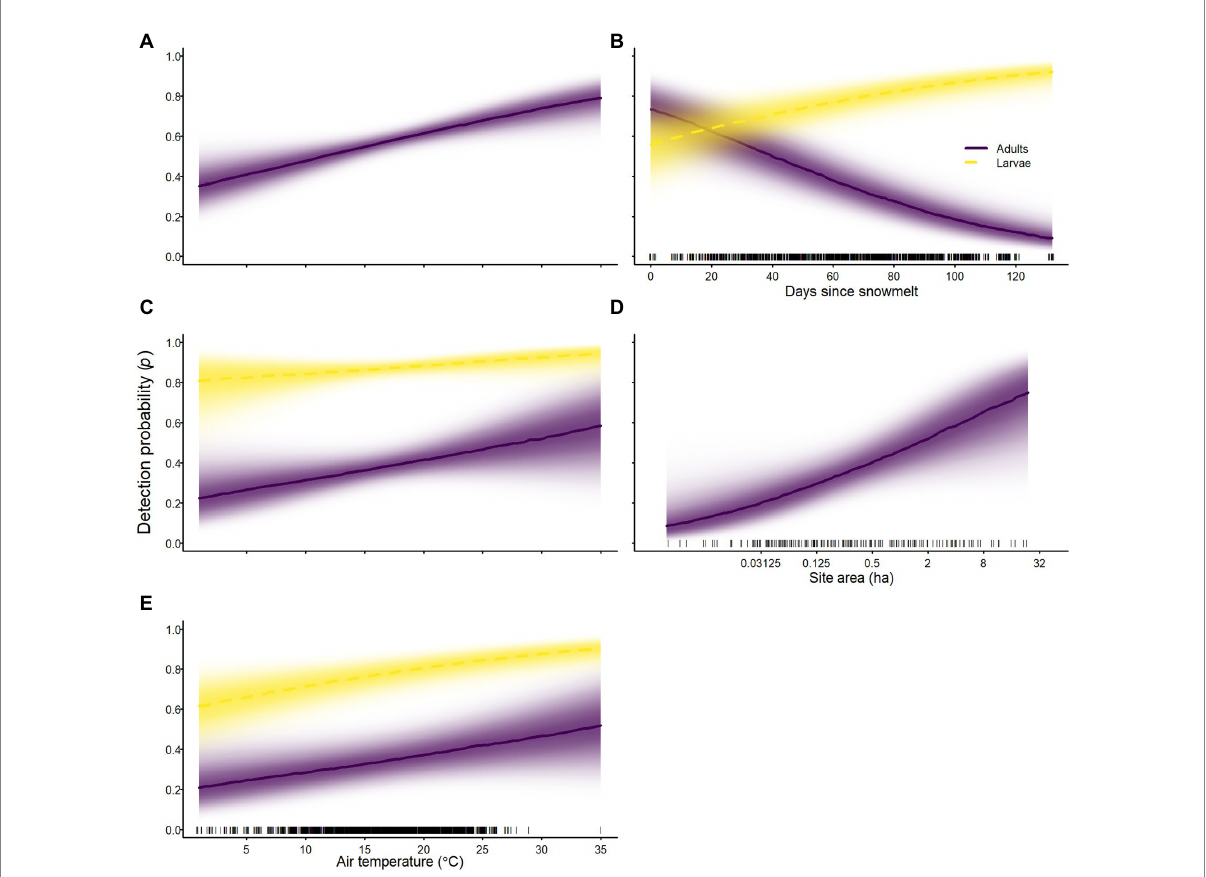
FIGURE 10 Probability of detection of Sierra Nevada yellow-legged frogs [ Rana sierrae ; (A) ], Yosemite toads [ Anaxyrus canorus ; (C) ], and sierran treefrogs [ Pseudacris sierra ; (B,D,E) ] in relation to air temperature (A,C,E) , days since snowmelt (B) , site area (D) , and life stage [adults (indigo solid lines and shading), larvae (gold dashed lines and shading)] in Yosemite National Park, California, United States, 2007–2021. Lines represent posterior modes; intensity of shading represents the posterior probability